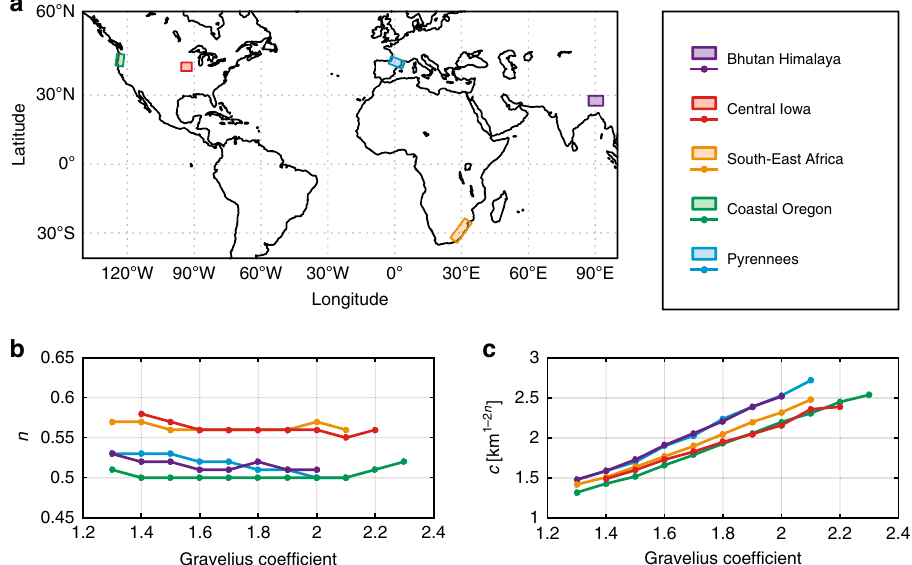
Fig. 8 Synthesis of results obtained for our global comparison. a Map showing the location of the fi ve studied region. b , c For all regions, Hack ’ s exponent n (shape-independent) and coef fi cient c (shape-dependent) exhibit similar trends with respect to the Gravelius Compacity coef fi